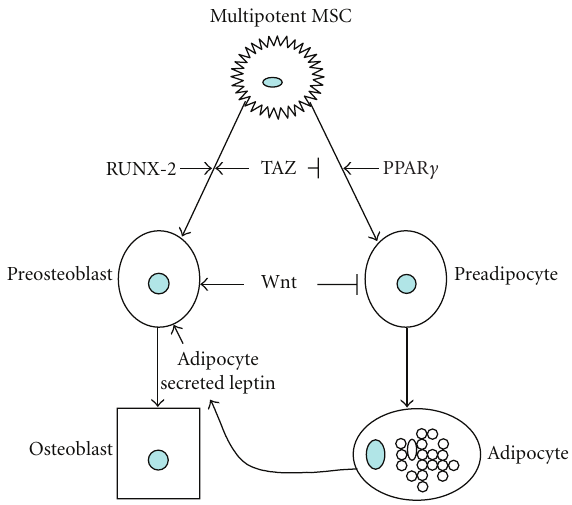
Figure 1: Factors governing normal osteogenesis and adipogenesis from mesenchymal stem cells. Multipotent mesenchymal stem cells can di ff erentiate into a number of cell types, including adipocytes and osteoblasts. ( ⊥ indicates inhibition; ↓ indicates stimulation). The transcriptional coactivator Taz negatively regulates adipoge- nesis and promotes osteogenesis through suppression of PPAR γ and activation of RUNX-2, while overexpression of PPAR γ can reduce bone formation. Also, a number of other factors such as secreted proteins from Wnt family promote the di ff erentiation and maintenance of osteoblasts while reducing the di ff erentiation of the adipocytes. In addition, factors secreted by mature adipocytes, such as leptin and estrogen, can increase bone mass in